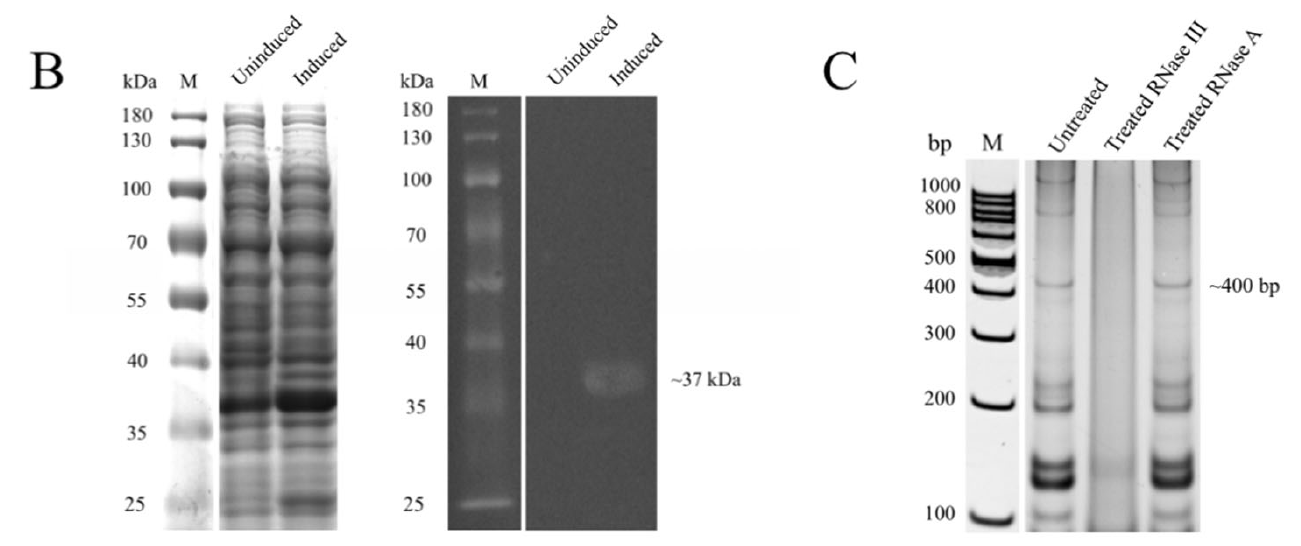
Figure 1. Construction of recombinant pET28a - Linked cp Pst DNV - ds pro vector and expression of its counterpart . ( A ) Schematic illustration for recombinant pET28a - Linked cp Pst DNV - ds pro . Asterisk indicates a stop codon. ( B ) SDS - PAGE and western blot analysis of total cell lysate from induced recombinant E . coli strain Rosetta - gami 2(DE3) pLysS . Lane M, PageRuler ™ Prestained Protein